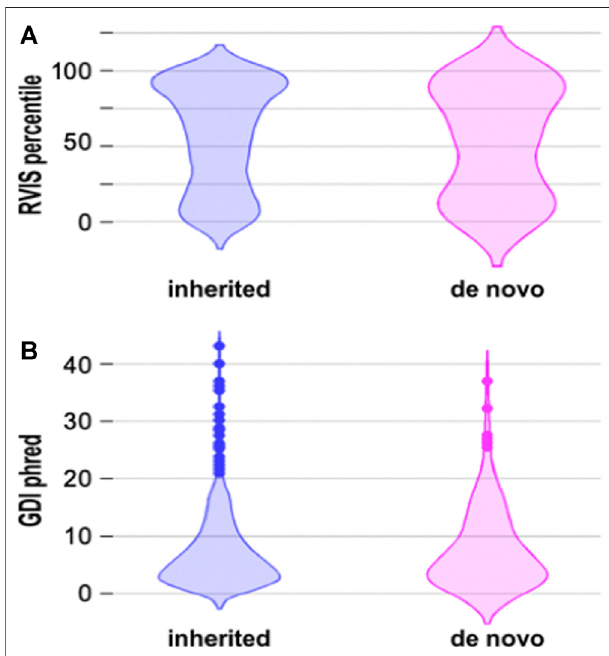
FIGURE 2 | Voilin plots for RVIS and GDI. (A) . Violin plots showing the RVIS percentile. Lower percentile indicates more “ intolerant ” variants. Statistical analysis with the two-tails Mann Whitney test did not reveal statistical differences between inherited and de novo mutations. (B) . Voilin plot showing the GDI phred. Lower GDI values indicate genes more prone to har-bour disease-causing mutations. Statistical analysis with the two-tails Mann Whitney test did not reveal statistical differences between inherited and de novo mutations.